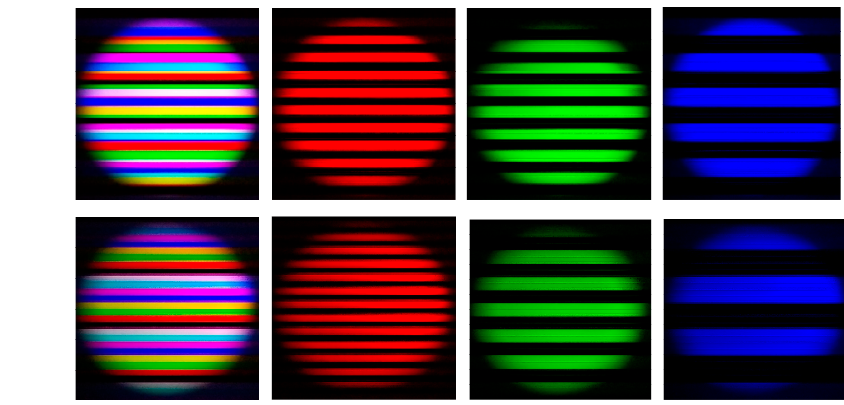
Figure 5. Different LED images captured using a CMOS sensor (2).